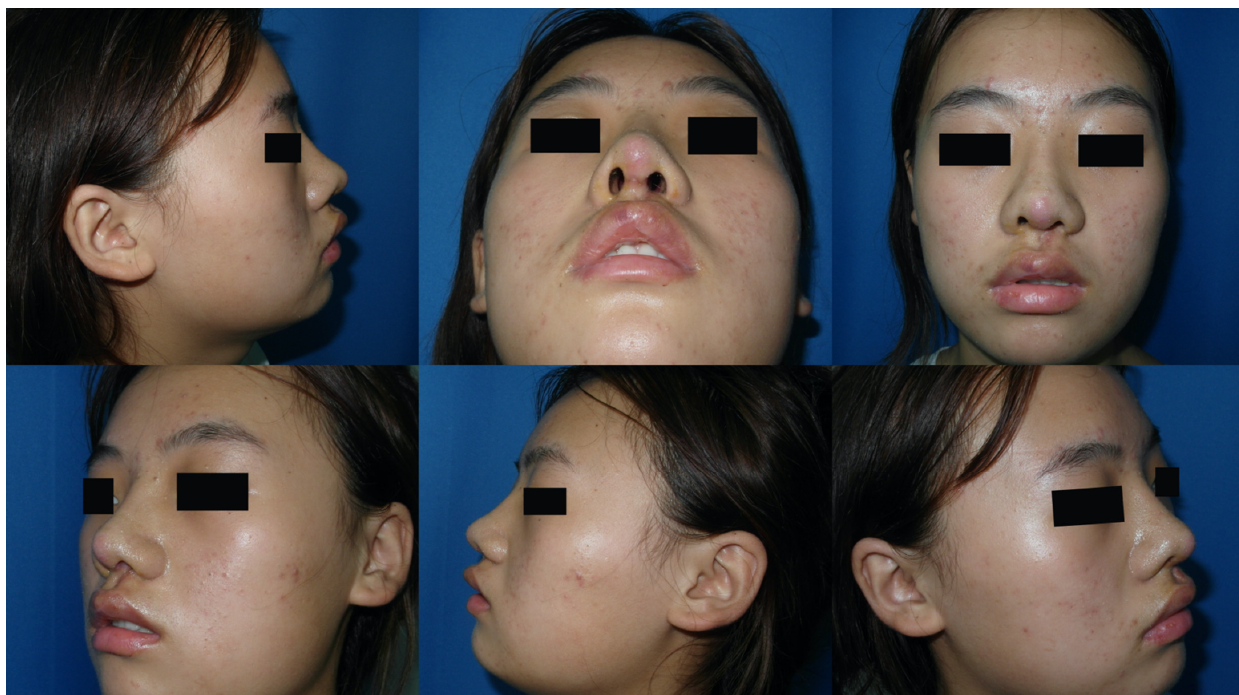
Figure 5. A 19-year-old female presented with cleft lip nasal deformity before our surgery. The photos were taken 6 months after the operation. Because of the premature absorption of the absorbable line, the nostrils were not exactly symmetrical. Further surgery could be taken to tighten the muscles of the nasal basis on the surgical side later in order to make the appearance more symmetrical.